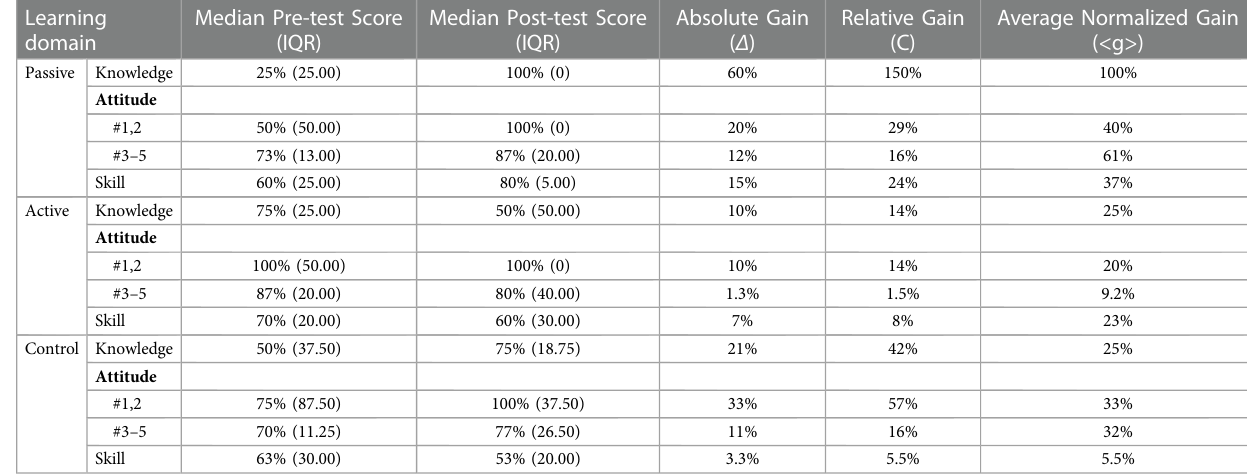
TABLE 2 Pre-test/post-test scores and learning gain across three groups. Robustness of educational intervention de fi ned if <g> is greater or equal to 30%. Learning